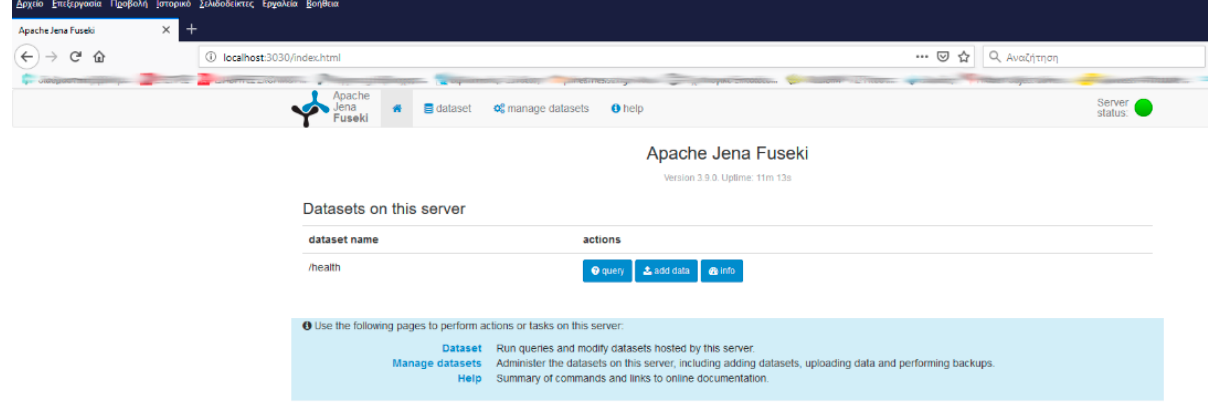
Figure 2. The “health” NoSQL database.